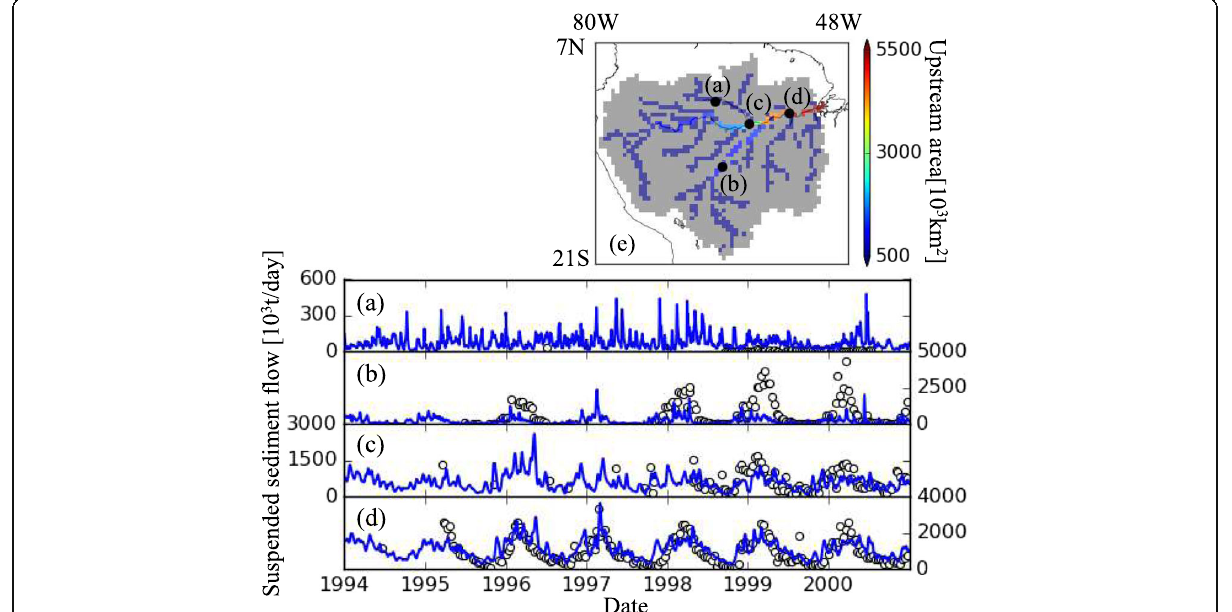
Fig. 2 Daily suspended sediment flow [10 3 tons/day] at a Serrinha, b Porto Velho, c Manacapuru, and d Obidos. Black circle indicates observation, blue line indicates CTL simulation. e Basin map. The background color indicates upstream area [10 3 km 2 ]. Gray grids indicate grids whose upstream area is smaller than 50,000 km